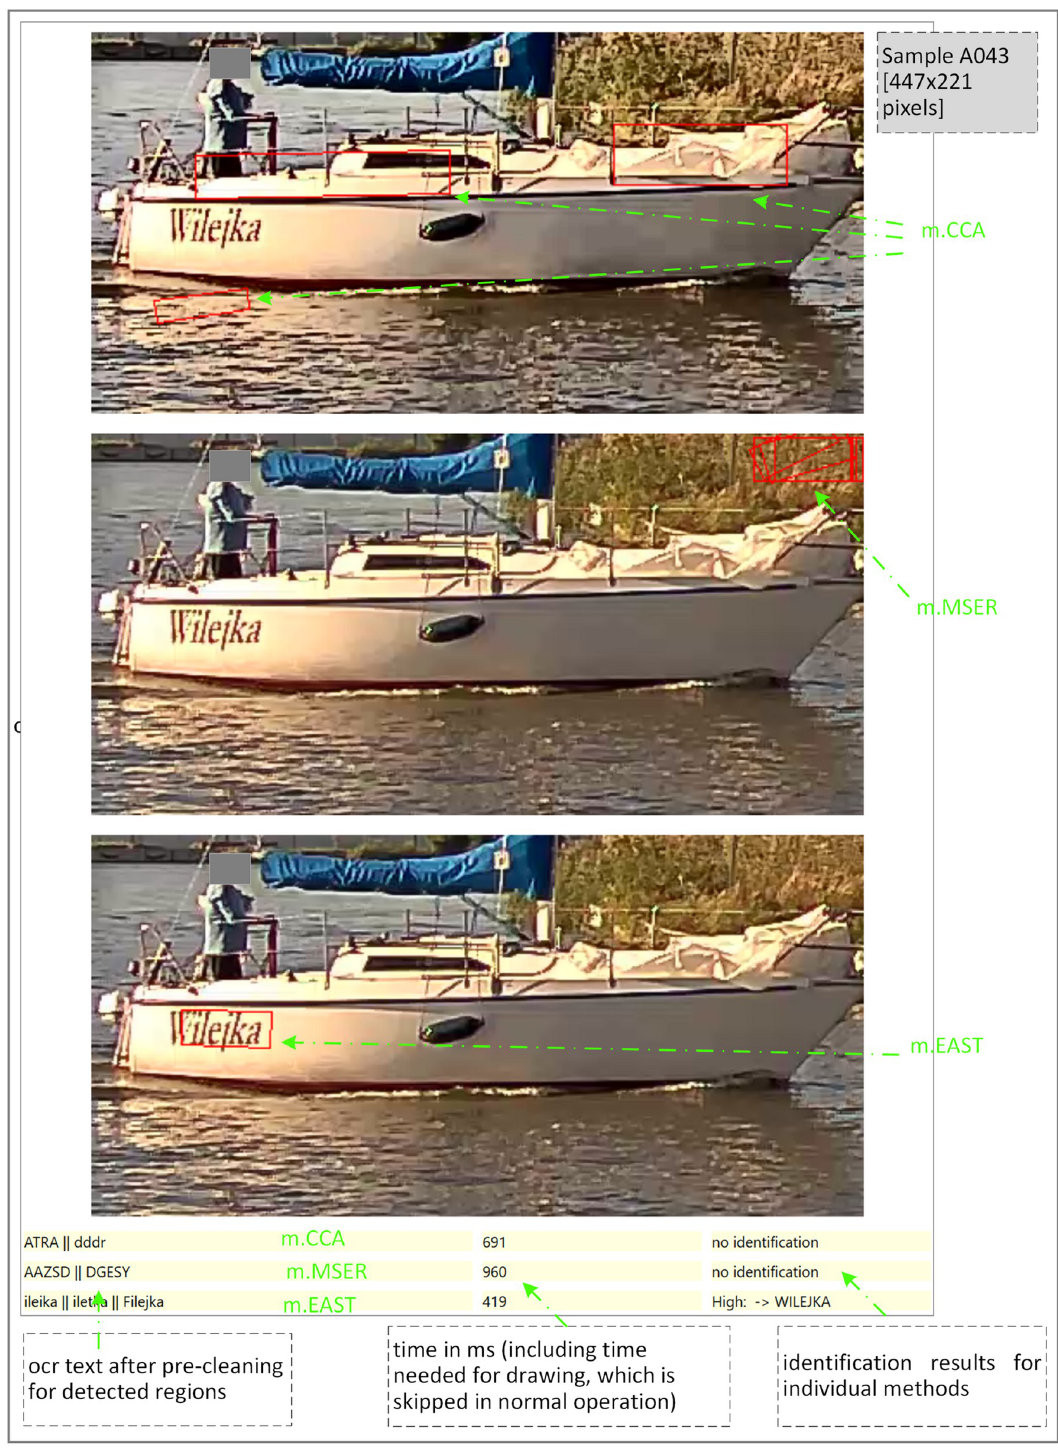
Fig 5. Example of text area localization by different methods in our data sets.